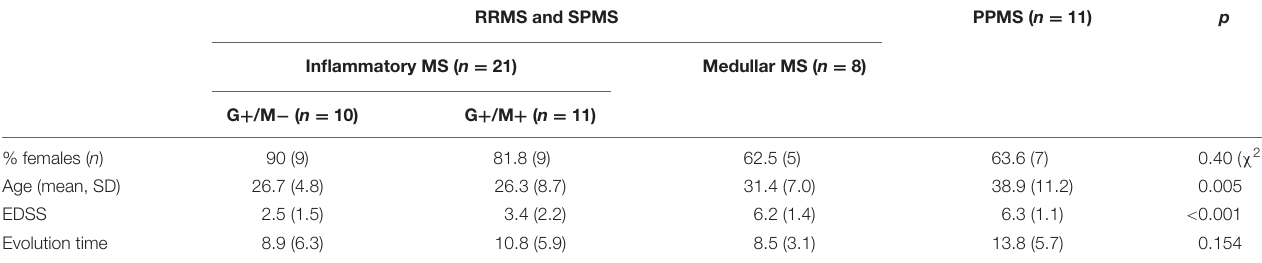
TABLE 6 | Characteristics of MS patients according to new proposal and working classification.